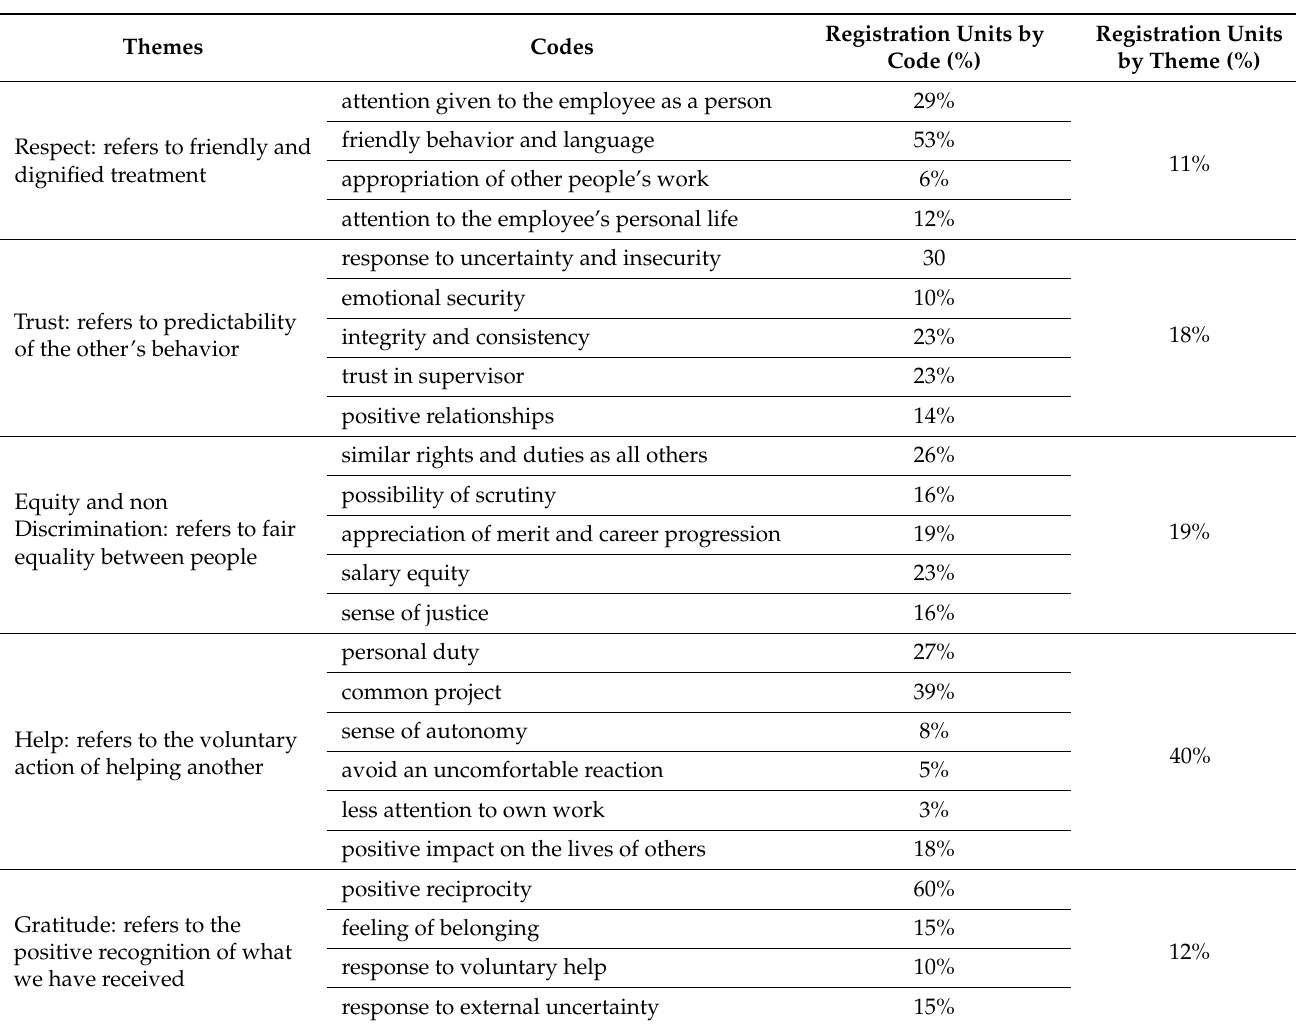
Table 1. The Most Important Social Values for Well-Being at